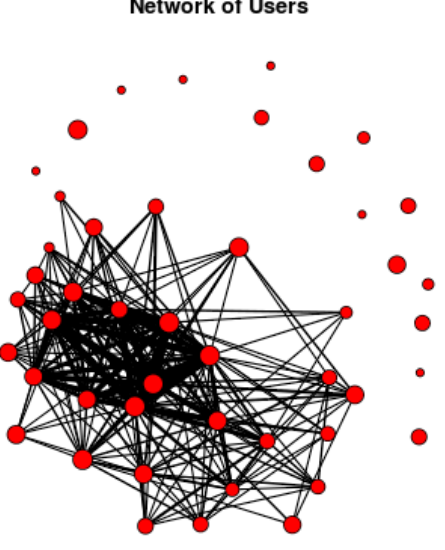
Figure 2. Plots of the 2-mode network (left), and member network (right). For the member network the width of an edge is determined by the edge value, and the size of the member node represents the number of threads that the user has